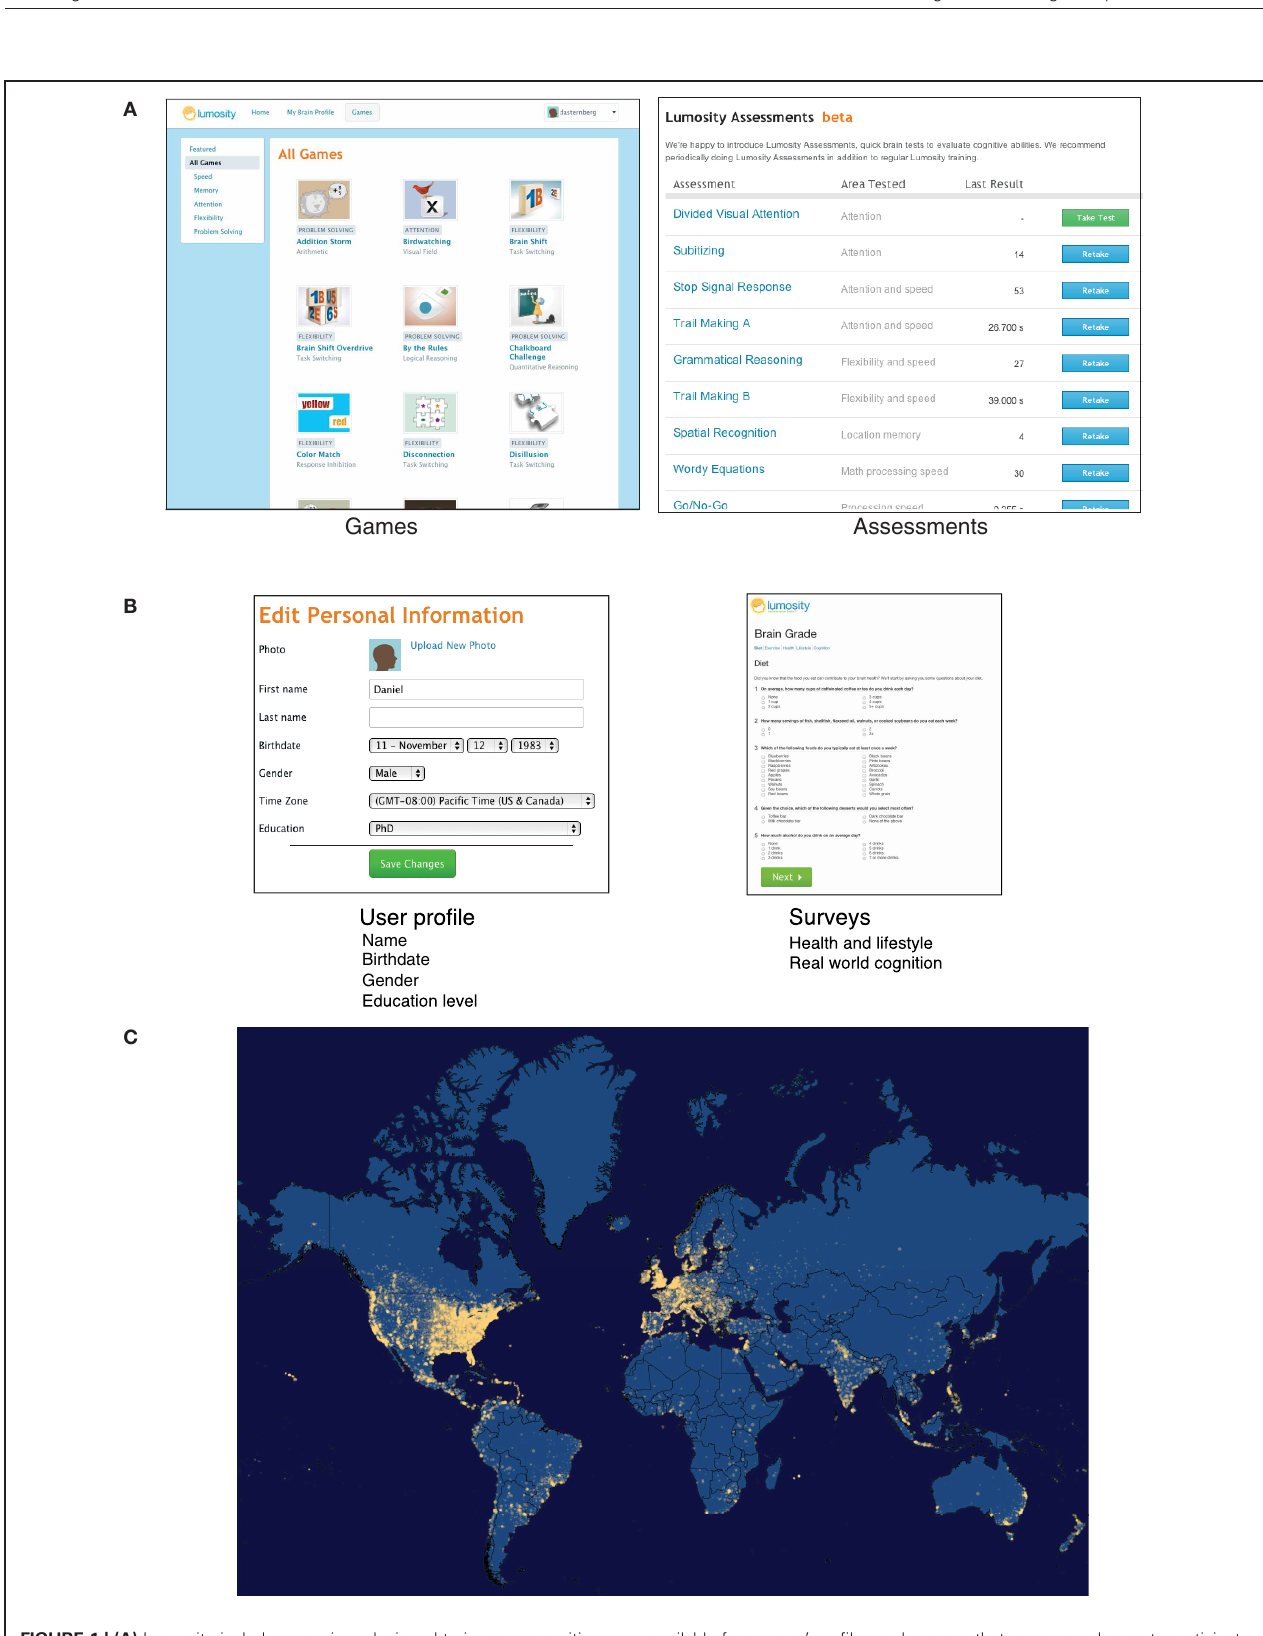
FIGURE 1 | (A) Lumosity includes exercises designed to improve cognitive performance targeting five areas of cognition, along with assessments based on standard neuropsychological tasks. (B) Demographic information is